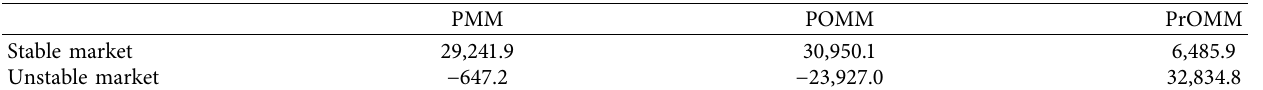
Table 6: Performances of HFT